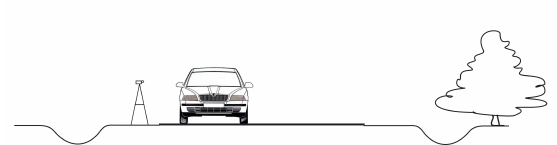
Figure 2. The position of the audio recorder with stereo microphones during on-road recordings in Ciecierzyn in the